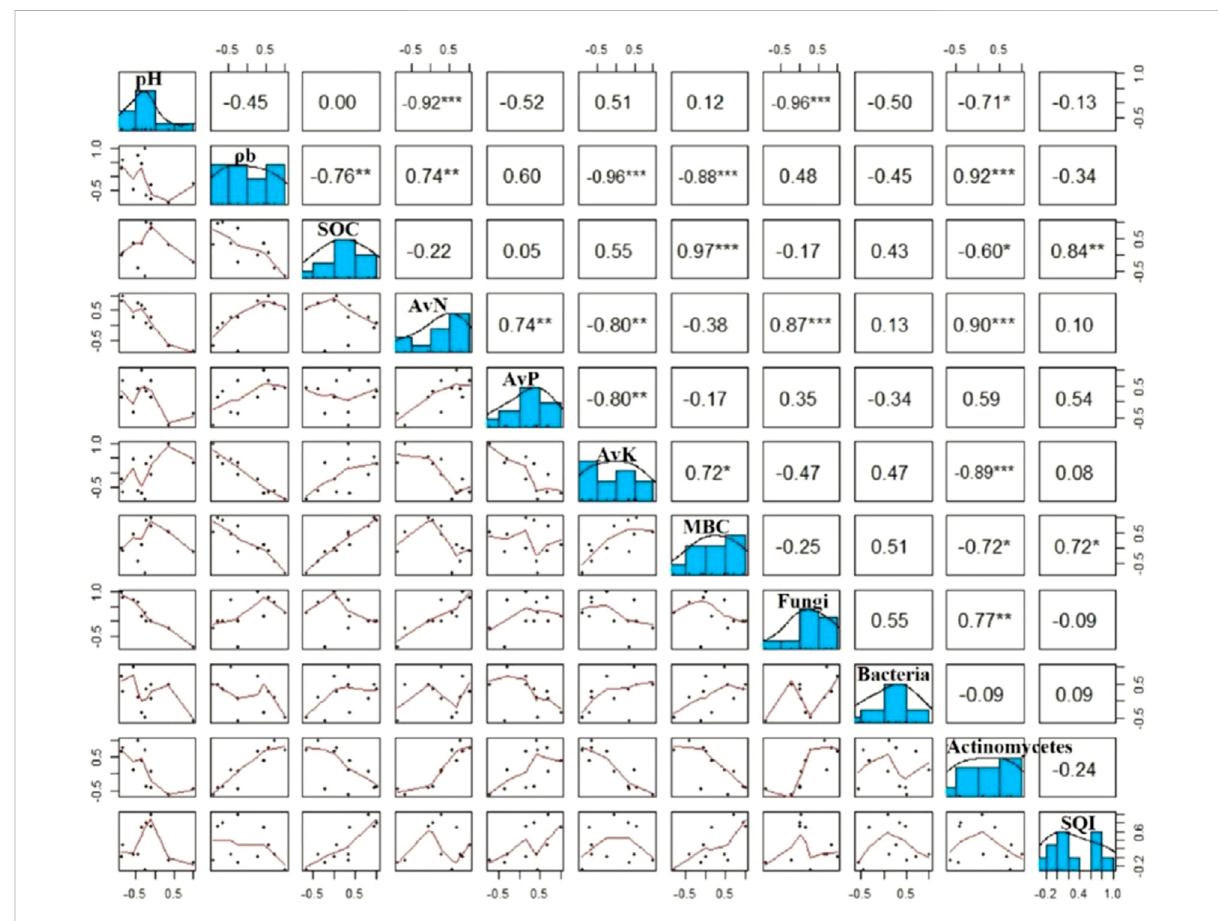
FIGURE 6 Correlations between soil quality indicators as in fl uenced by spatial variation and crop management in the rice – wheat cropping system. pb: bulk density, SOC: soil organic carbon; AvN: available nitrogen, AvP: available phosphorus, AvK: available potassium, microbial biomass carbon, SQI: soil quality